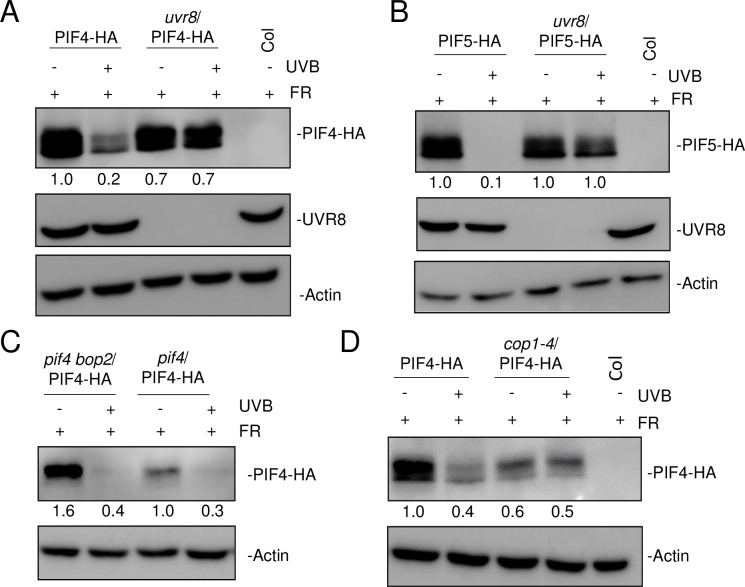
UVR8 induces PIF4 and PIF5 degradation in response to UV-B, independently of BOP2.Anti-HA immunoblot analysis of HA-tagged PIF4 and PIF5 proteins in 7-day-old seedlings grown in long-day conditions under white light and exposed to low R:FR with (+) or without (-) 3-h supplemental narrowband UV-B at ZT3. Wild type (Col) is shown as negative control. (A) PIF4-HA protein levels were analyzed in Col/ProPIF4:PIF4-3xHA (PIF4-HA) and uvr8-6/ProPIF4:PIF4-3xHA (uvr8/PIF4-HA). (B) PIF5-HA protein levels were analyzed in Col/ProPIF5:PIF5-3xHA (PIF5-HA) and uvr8-6/ProPIF5:PIF5-3xHA (uvr8/PIF5-HA). (C) PIF4-HA protein levels were analyzed in pif4-101/ProPIF4:PIF4-3xHA (pif4/PIF4-HA) and pif4-101 bop2-2/ProPIF4:PIF4-3xHA (pif4 bop2/PIF4-HA). (D) PIF4-HA protein levels were analyzed in Col/ProPIF4:PIF4-3xHA (PIF4-HA) and cop1-4/ProPIF4:PIF4-3xHA (cop1-4/PIF4-HA). Blots were re-probed with anti-UVR8 (A and B) as well as anti-actin as loading control (A–D). Numbers under lanes indicate relative band intensities.